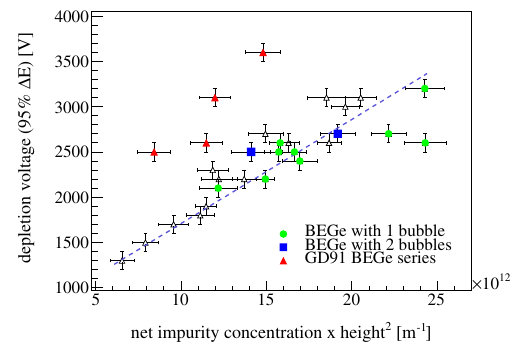
Fig. 6 Correlation between the full depletion voltage V d ( 95% Δ E ) and the product of the net impurityconcentration and the squared height for all 30 Gerda Phase II BEGe detectors except for GD02D. Open symbols pertain to detectors with no appearance of the ‘bubble deple- tion’ effect or which do not belong to the GD91 series. The dashed line results from the fit to these 25 data points